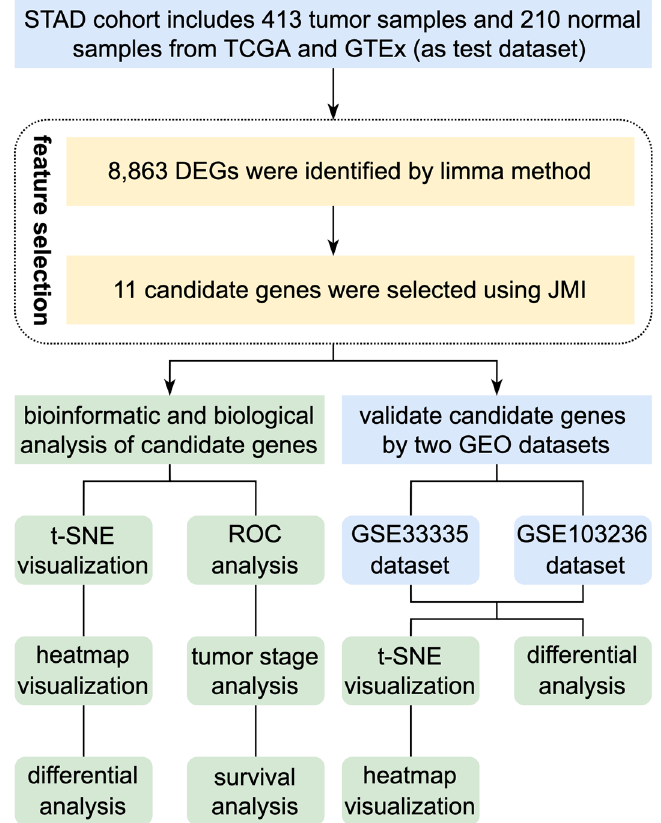
Figure 1. Design and workflow of the study. STAD stomach adenocarcinoma; TCGA The Cancer Genome Atlas, GTEx Genotype-Tissue Expression, DEGs differentially expressed genes, JMI joint mutual